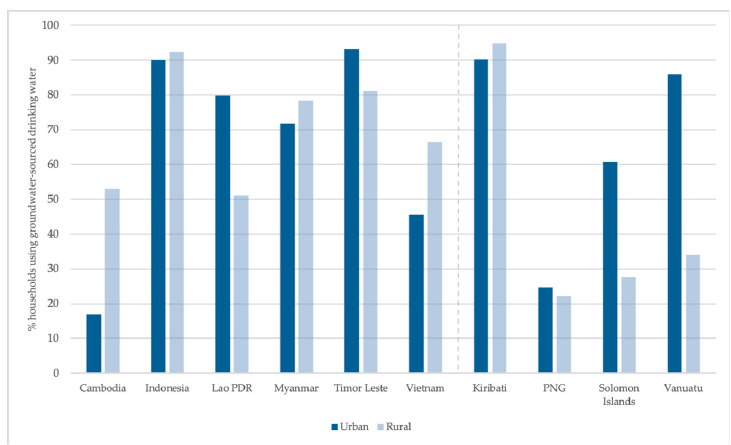
Figure 1. Proportion of households using groundwater as their primary source of drinking water in urban and rural areas across case study countries.